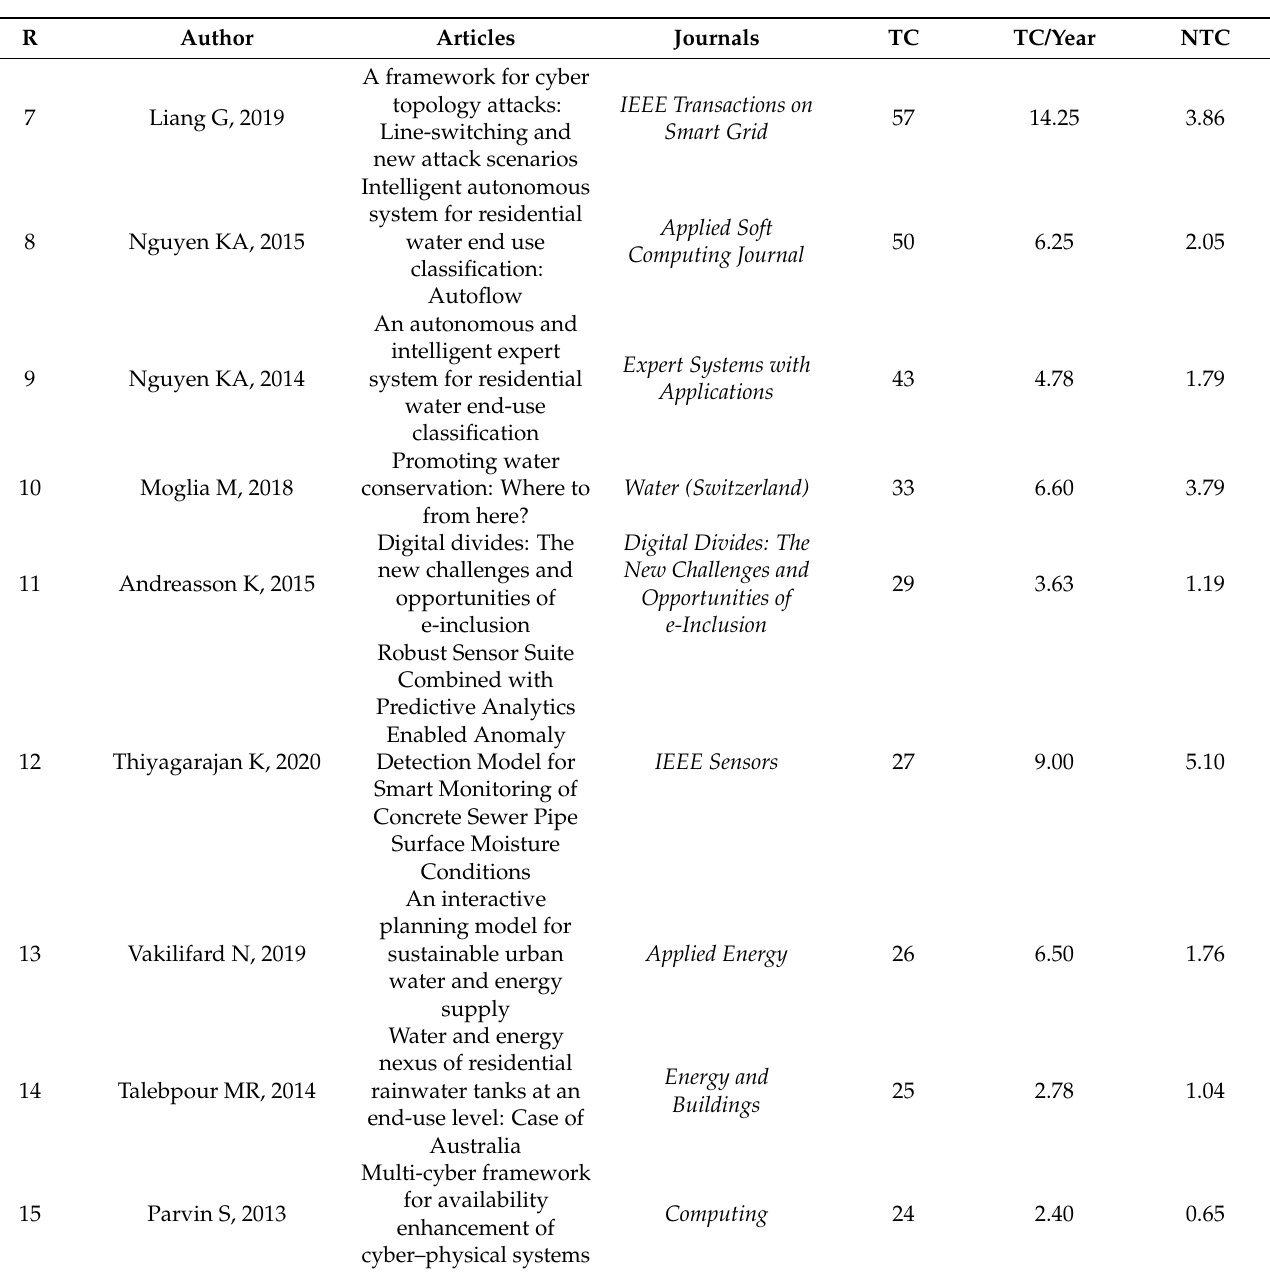
Table 5 answers RQ3.5 regarding identifying the target venues for publishing